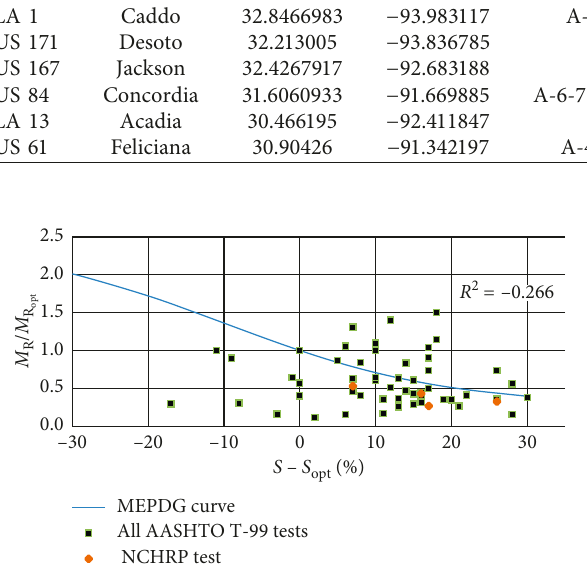
Figure 2: MEPDG curve for fine-grained soils with all points.